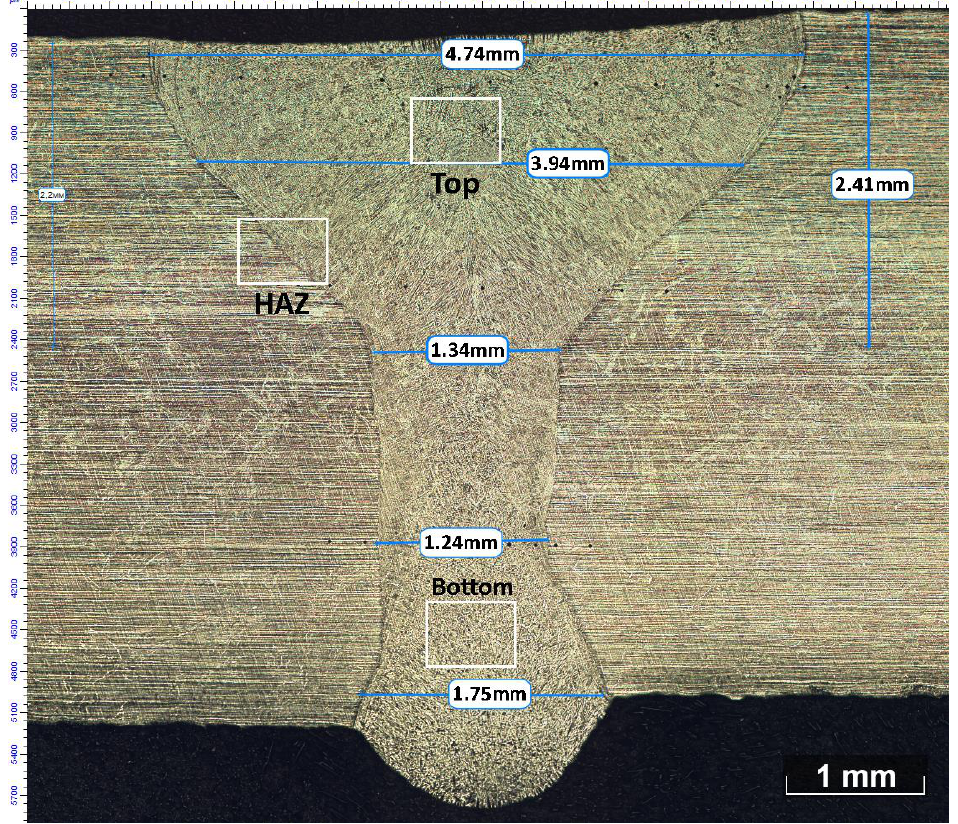
Figure 1. Macrostructure of as-welded sample (NHT – No Heat Treatment); white squares–zones shown in a next figure.